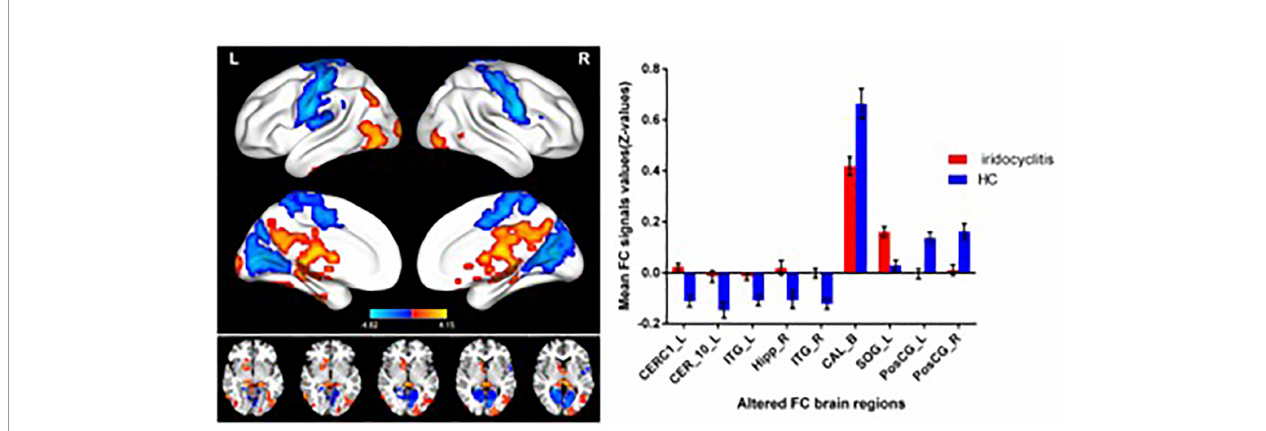
FIGURE 3 | Brain areas with statistically signi fi cant differences between two groups in FC of the left V1. Signi fi cantly FC differences were shown between the left V1 and CERC1_L, CER_10_L, ITG_L, Hipp_R, ITG_R, CAL_B, SOG_L, PosCG_L and PosCG_R. (voxel-level P <0.01, GRF correction, cluster-level P <0.05). FC, functional connectivity; CERC1_L, left cerebellum crus1; CER_10_L, left cerebellum 10; ITG_L, left inferior temporal gyrus; Hipp_R, right hippocampus; ITG_R, right inferior temporal gyrus; CAL_B, bilateral calcarine; SOG_L, left superior occipital gyrus; PosCG_L, left postcentral gyrus; PosCG_R, right postcentral gyrus.